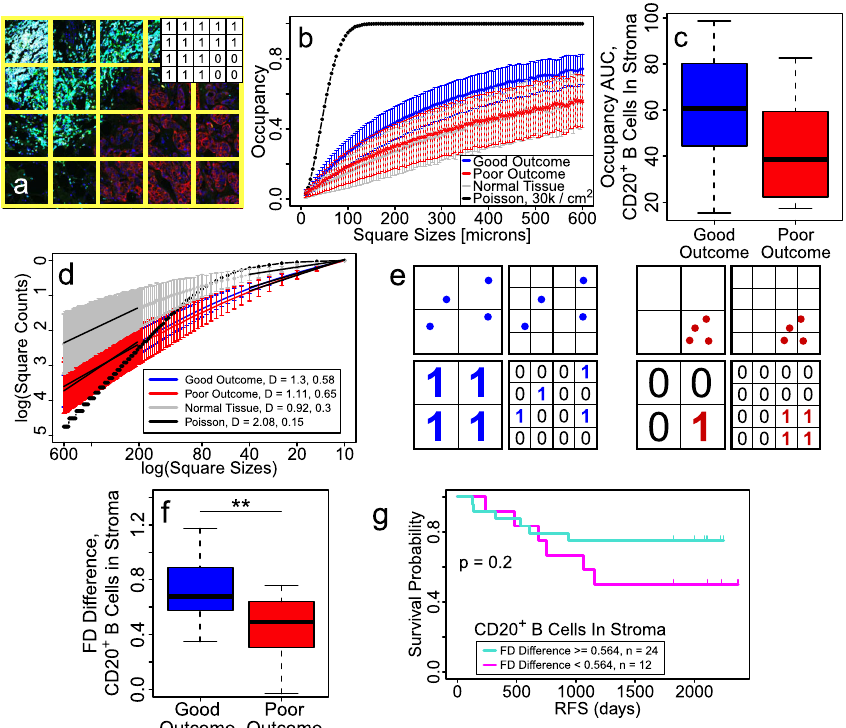
Fig. 2 Occupancy, fractal dimensions, and FD differences indicate that stromal B cells are more spread out in good outcome. a – c Occupancy: a Example image showing how occupancy is computed. A grid of squares placed over the image. (Inset) 1 ’ s (0 ’ s) correspond to yes (no) answers to a binary question asked of each square, e.g., “ Is there at least one B cell in the square? ” Occupancy is fraction of squares with 1 ’ s. b Plot of CD20 + B cell occupancy in stroma vs. square size for good clinical outcome (blue), poor clinical outcome (red), normal breast tissue (black) and points randomly distributed according to a uniform Poisson process with a density of 3 × 10 2 points/mm 2 (cyan). Error bars indicate 95% con fi dence intervals. Good (blue) outcome curve is consistently higher than poor (red) outcome curve. c Plots showing occupancy area under the curve (AUC) for CD20 + B cells in stroma is higher for good ( n = 24) vs. poor ( n = 12) outcome ( p = 0.05). Center line represents the median, box limits represent the upper and lower quartiles, whiskers indicate maximum and minimum values within 1.5 interquartile ranges of the upper and lower quartiles; individual points are outliers. d Fractal dimension determined from slope of the log-log plot of the number of squares with at least one stromal CD20 + B cell vs. the inverse box size (Logarithms are base e ). The fractal dimension is larger for good clinical outcome vs. poor outcome at large length scales, but this trend is reversed at small length scales. At long length scales (200 – 600 μ m on the left side of the plot), mean fractal dimension s (slope) is 1.3 for good outcome (blue), 1.11 for poor outcome (red), 0.92 for normal tissue (gray), and 2.08 for Poisson (black). The p value for good vs. poor outcome is 0.08 at long length scales. At short length scales (10 – 40 μ m on the right side of the plot), the mean fractal dimension is 0.58 for good outcome, 0.65 for poor outcome, 0.30 for normal tissue, and 0.15 for Poisson. The p value for good vs. poor outcome is 0.5 at short length scales. Black dashed lines show least-squares linear regression fi t at long and short length scales. Because different images have different overall areas, fractal dimension is calculated by normalizing the number n(L) of boxes with 1 ’ s with the total number N(L) of boxes with cells. Thus the y-axis values are negative. The error bars correspond to 95% con fi dence intervals. e Example illustrating how FD difference indicates whether cells are spread out or clustered. The left image with four quadrants shows four blue points that are spatially spread out in the upper two quadrants while the right image with four quadrants shows four clustered red points in the upper two quadrants. At long length scales (big boxes in left 2 quadrants), the big squares in the lower left quadrant have more 1 s in the left image than in the lower left quadrant of the right image because the blue points in the upper left quadrant are more spread out compared to the red points in the upper left quadrant of the right image, so the fractal dimension is larger in the left half of left image than in the left half of the right image. At small length scales (small boxes in 2 right quadrants), the upper right quadrants of both images have the same number of points and occupy the same number of squares; hence, the blue and red points have the same fractal dimension at small length scales. So the difference in fractal dimension between large and small length scales will be larger for the spatially dispersed blue points than for the clustered red points. f Plot showing that the FD difference for stromal CD20 + B cells is signi fi cantly higher in good outcome ( p = 3 × 10 − 3 , ROC AUC = 0.77), indicating that B cells are more spatially dispersed in the stroma in good outcome. Center line represents the median, box limits represent the upper and lower quartiles, whiskers indicate maximum and minimum values within 1.5 interquartile ranges of the upper and lower quartiles; individual points are outliers. g RFS plot showing the clinical signi fi cance of the FD difference for stromal CD20 + B cells with a threshold value = 0.564 (see “ Methods ” ). For all FD differences calculated in this paper, the large length scale range is 200 – 600 μ m and the small length scale range is 10 – 40 μ m. Patient cohorts for all plots in this fi gure are n = 24 for good outcome (blue) and n = 12 for poor outcome (red). P -values in box plots are determined by unpaired, two-tailed